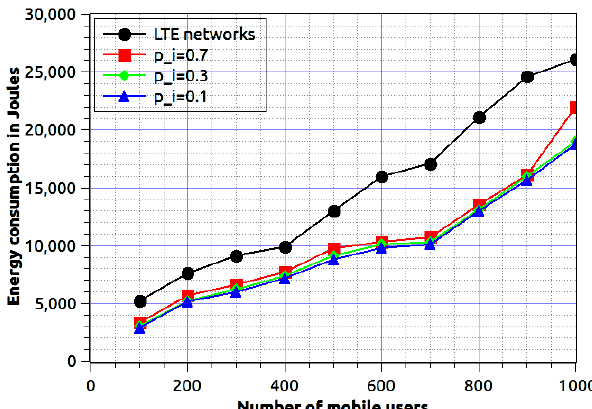
Figure 11. Number of active mobile users using device-driven communication with various level of node mobility verses energy consumption in